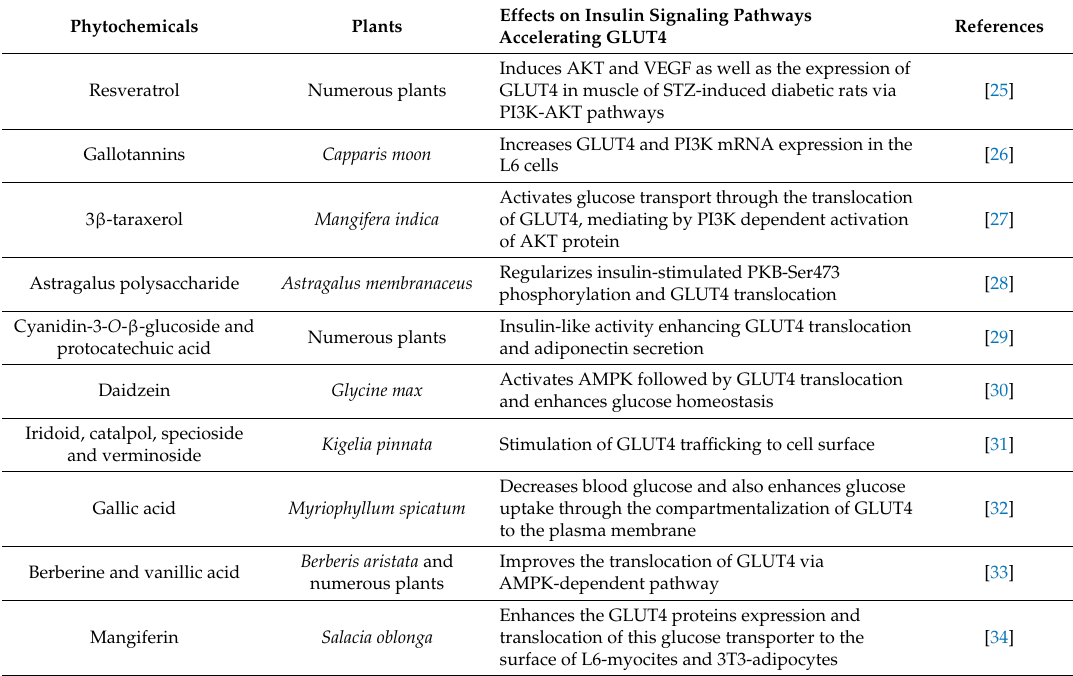
Table 1. Some reported antidiabetic effects of phytochemicals on insulin signaling pathways accelerating glucose transporter isoform 4